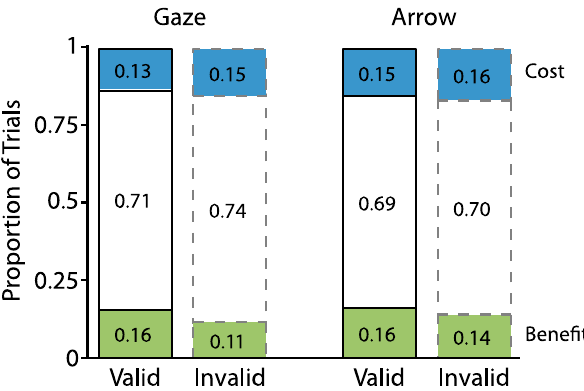
Figure 6. Cumulative proportion of trials for Experiment 2 classified as benefits (green), costs (blue), and other trials (white).